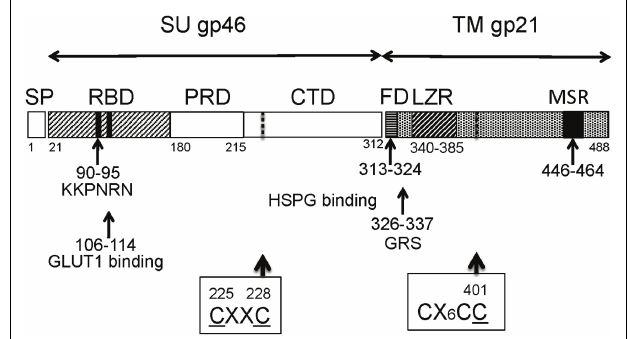
FIGURE 3 |The structure of Env proteins. The CXXC and CX6CC motifs are shown by dotted lines. Abbreviations: SP, signal peptide; RBD, receptor-binding domain; PRD, proline-rich domain; CTD, C-terminal domain; FD, fusion domain; GRS, glycine-rich segment; LZR, leucine zipper-like region; MSR, membrane-spanning